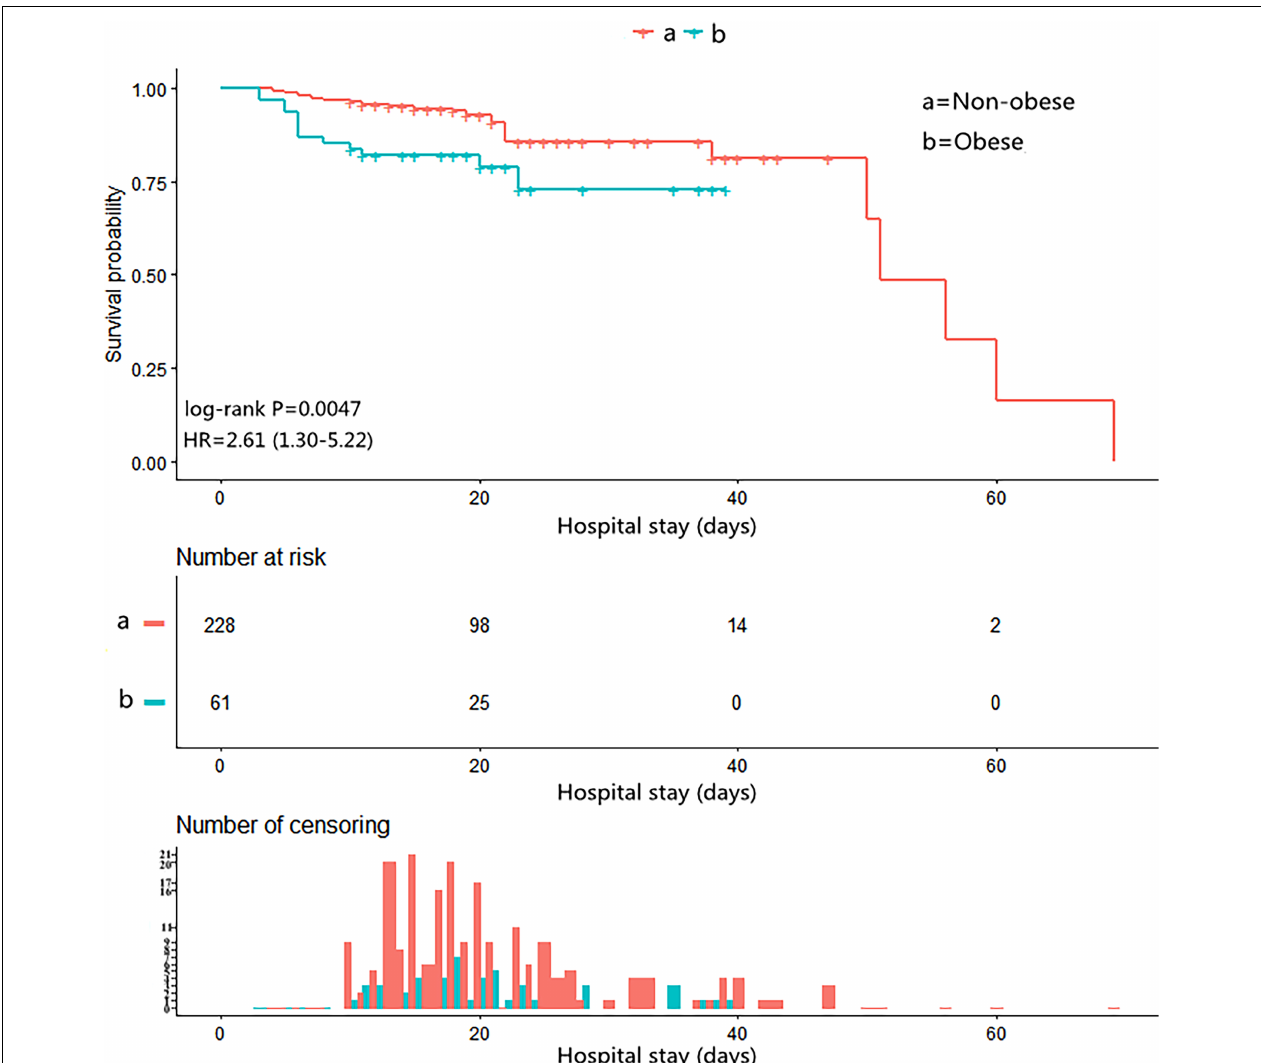
FIGURE 2 | The Kaplan–Meier curves for in-hospital survival in the chronological trend after open surgical repair in AAD.